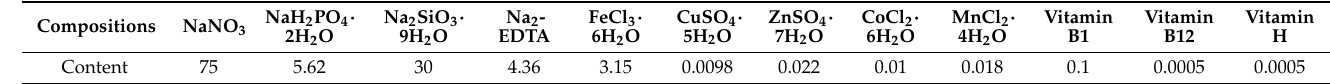
Table 5. Compositions of F/2 medium used for this study, (mg/1 L artificial seawater).